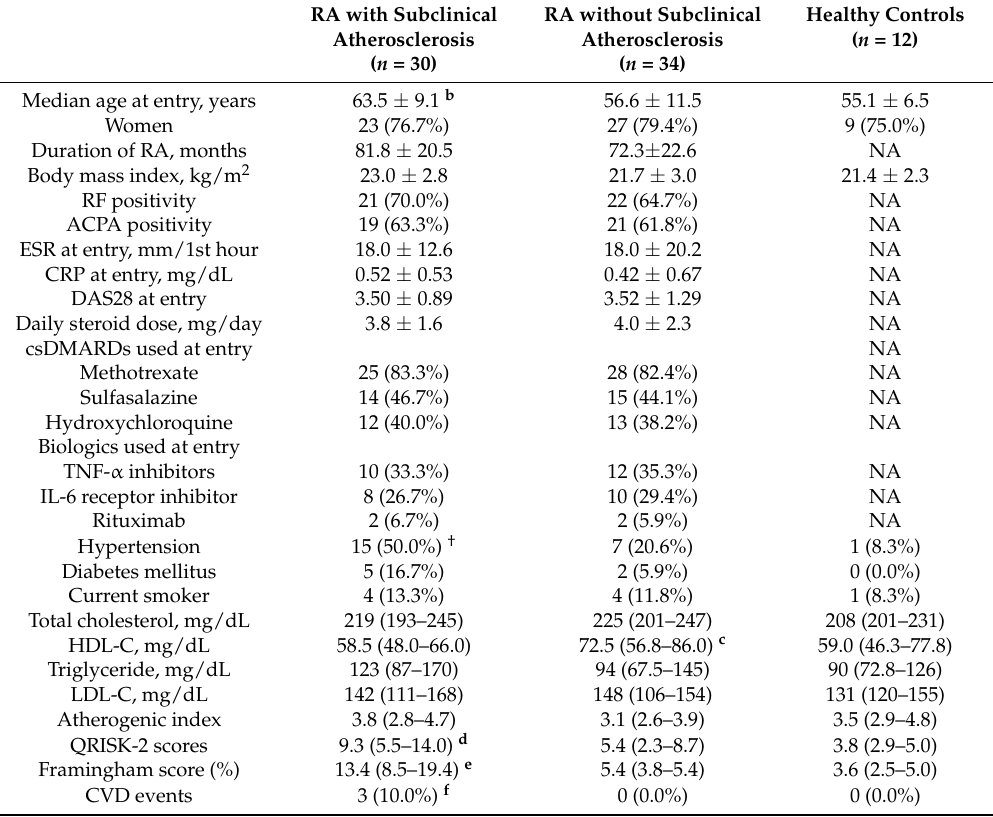
Table 1. Demographic data and laboratory data in rheumatoid arthritis (RA) patients with or without subclinical atherosclerosis as shown by carotid ultrasonography a